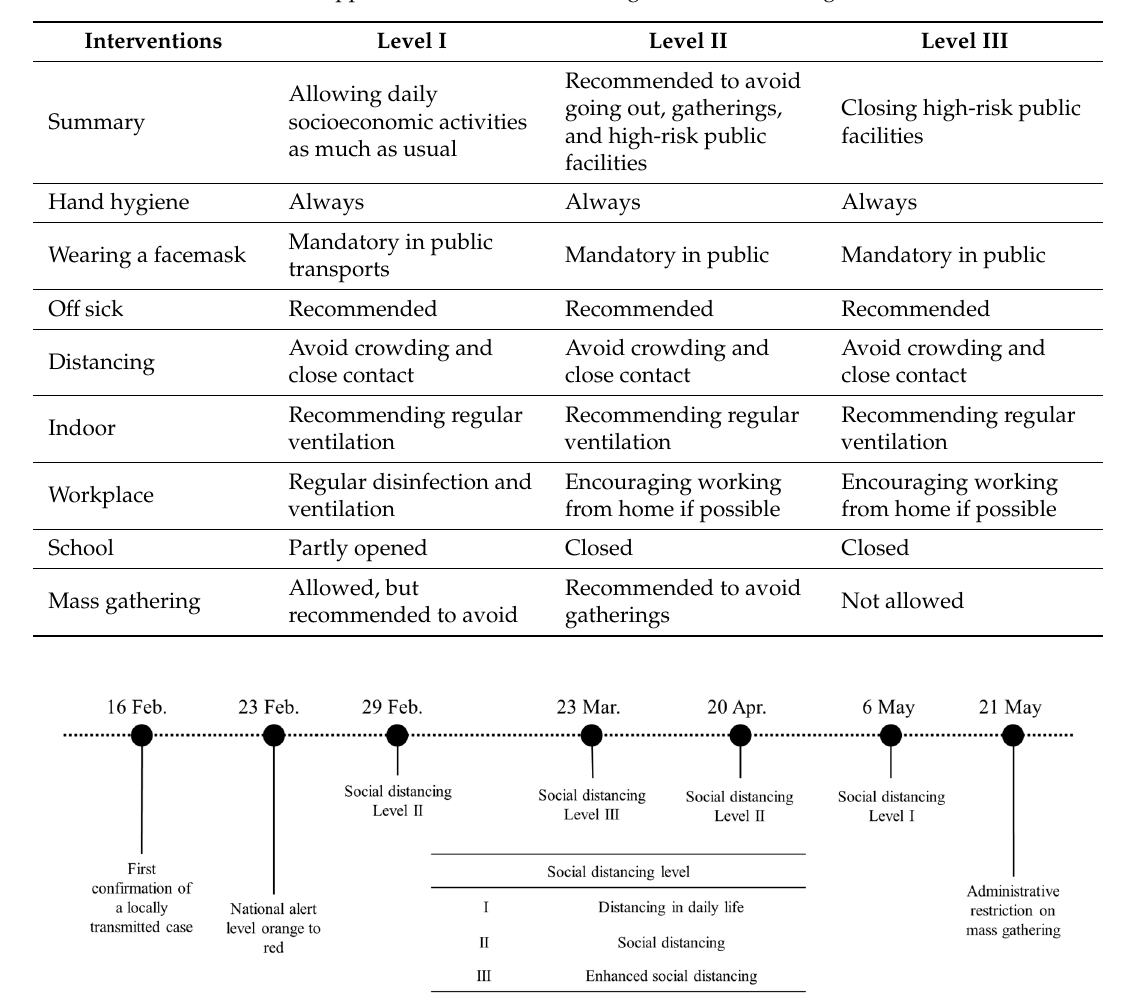
Table 1. Applied interventions according to social distancing levels.